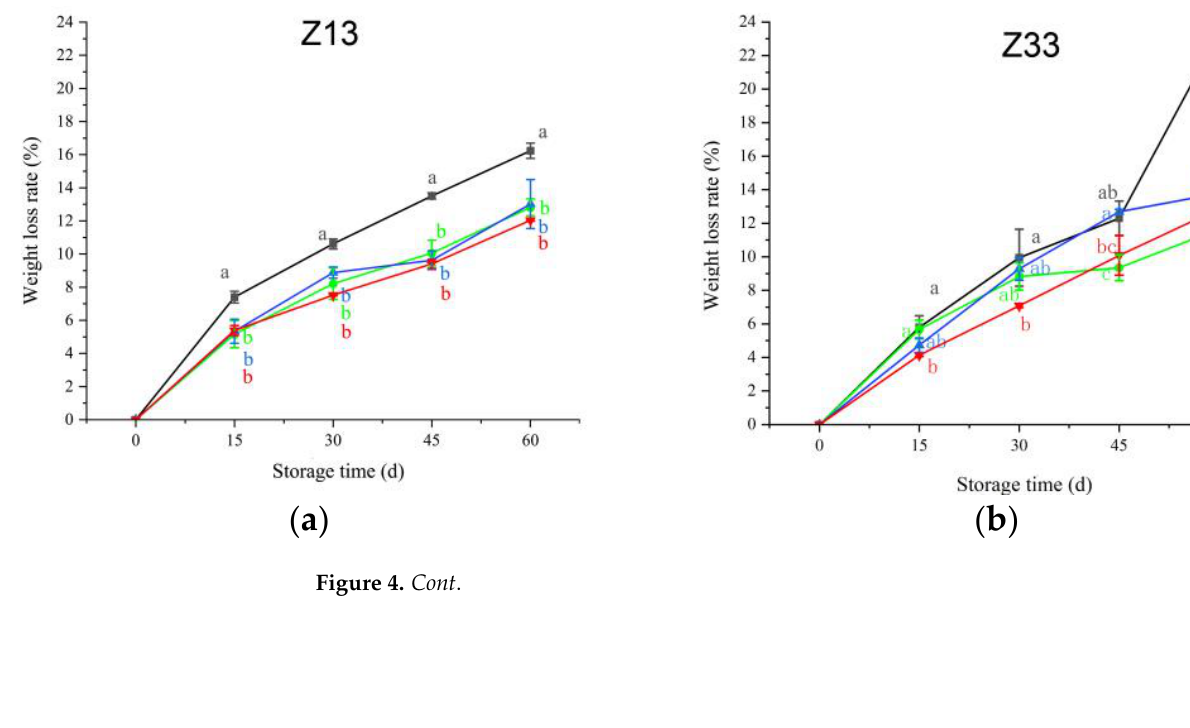
( c ) Figure 4. Weight loss rate of the tuberous root of different UCZ treatments during storage. ( a ) Z13; ( b ) Z33; ( c ) J26. Values within the same storage day of the same year followed by the same letter are not significantly different at the 5% level according to ANOVA- Duncan’s multiple range test. K1: Normal basal fertilizing without UCZ; K2: Normal basal fertilizing with UCZ; K3: Rich basal fertilizing without UCZ; K4: Rich basal fertilizing with UCZ.